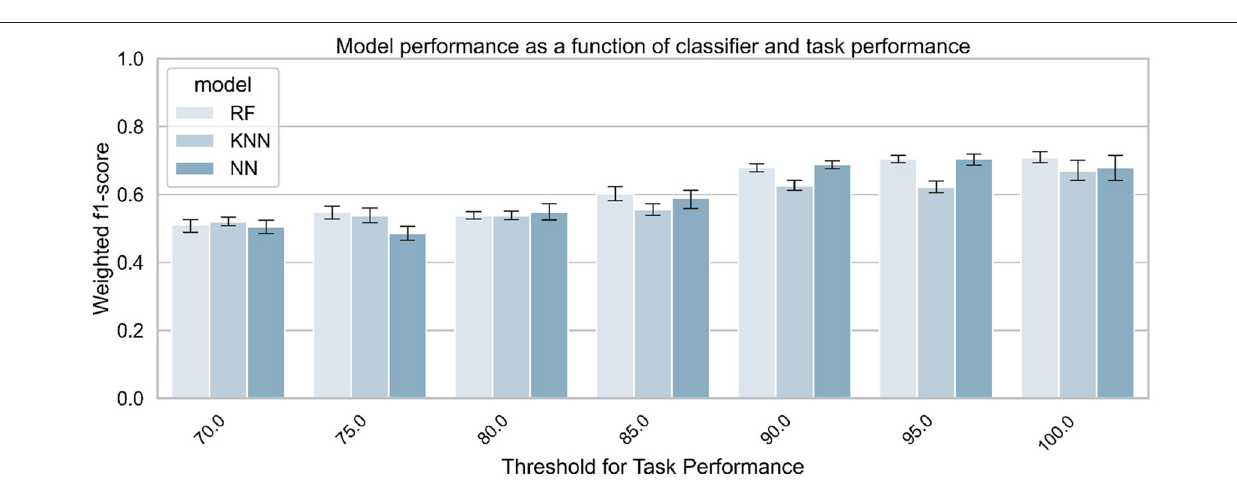
signal combination on the test set over the 5 iterations. Table